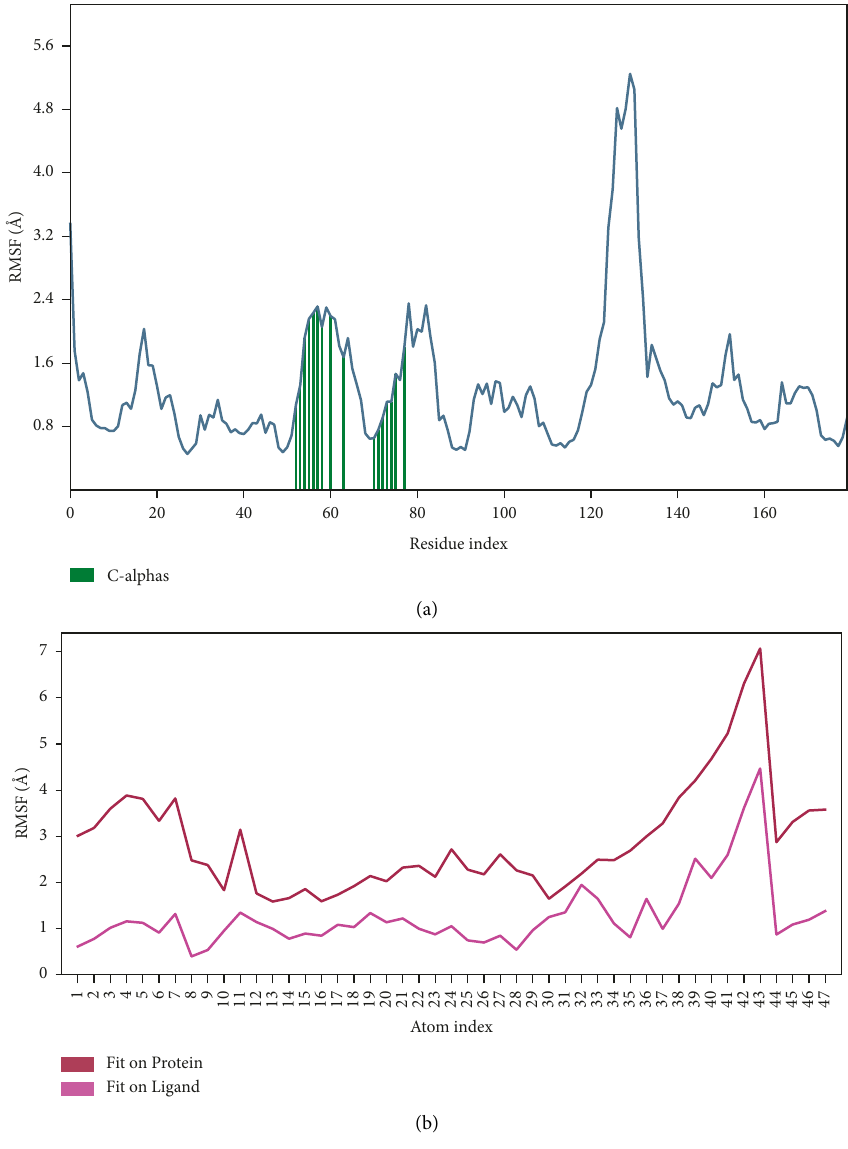
Figure 5: Plot of protein-ligand RMSF. (a) Protein RMSF. (b) Ligand